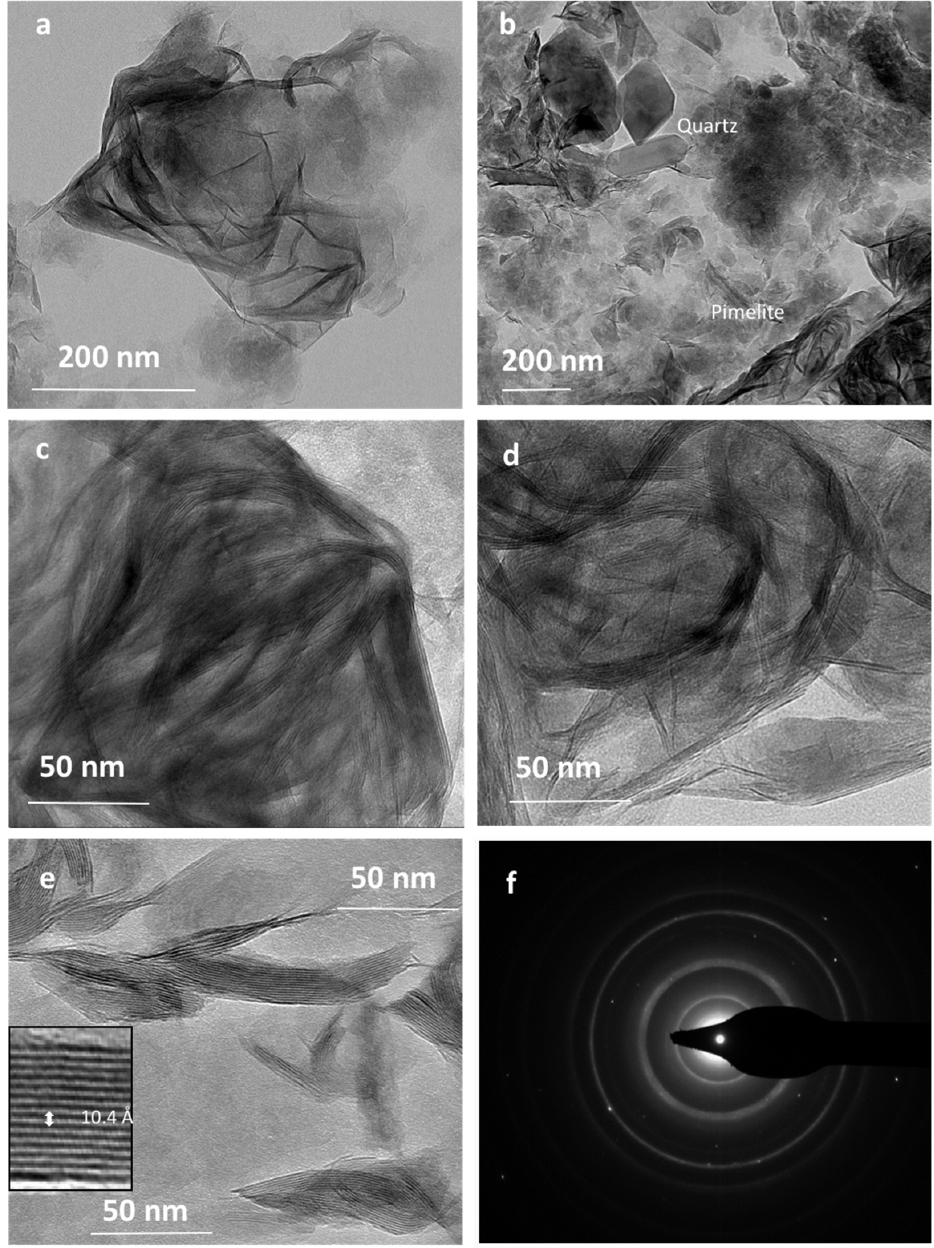
Figure 7. ( a ) TEM images of the Ni-silicate (pimelite). ( b ) Pimelite and euhedral quartz. ( c , d ) Flexuous assemblage of small size pimelite particles. ( e ) HRTEM image showing that the number of talc-like layers is generally low, about 5 to 15 in each particle, with no interstrati fi cation with other minerals. Indicative layer spacing is provided. ( f ) Di ff raction pa tt ern of one pimelite particle, with talc-like spacing.